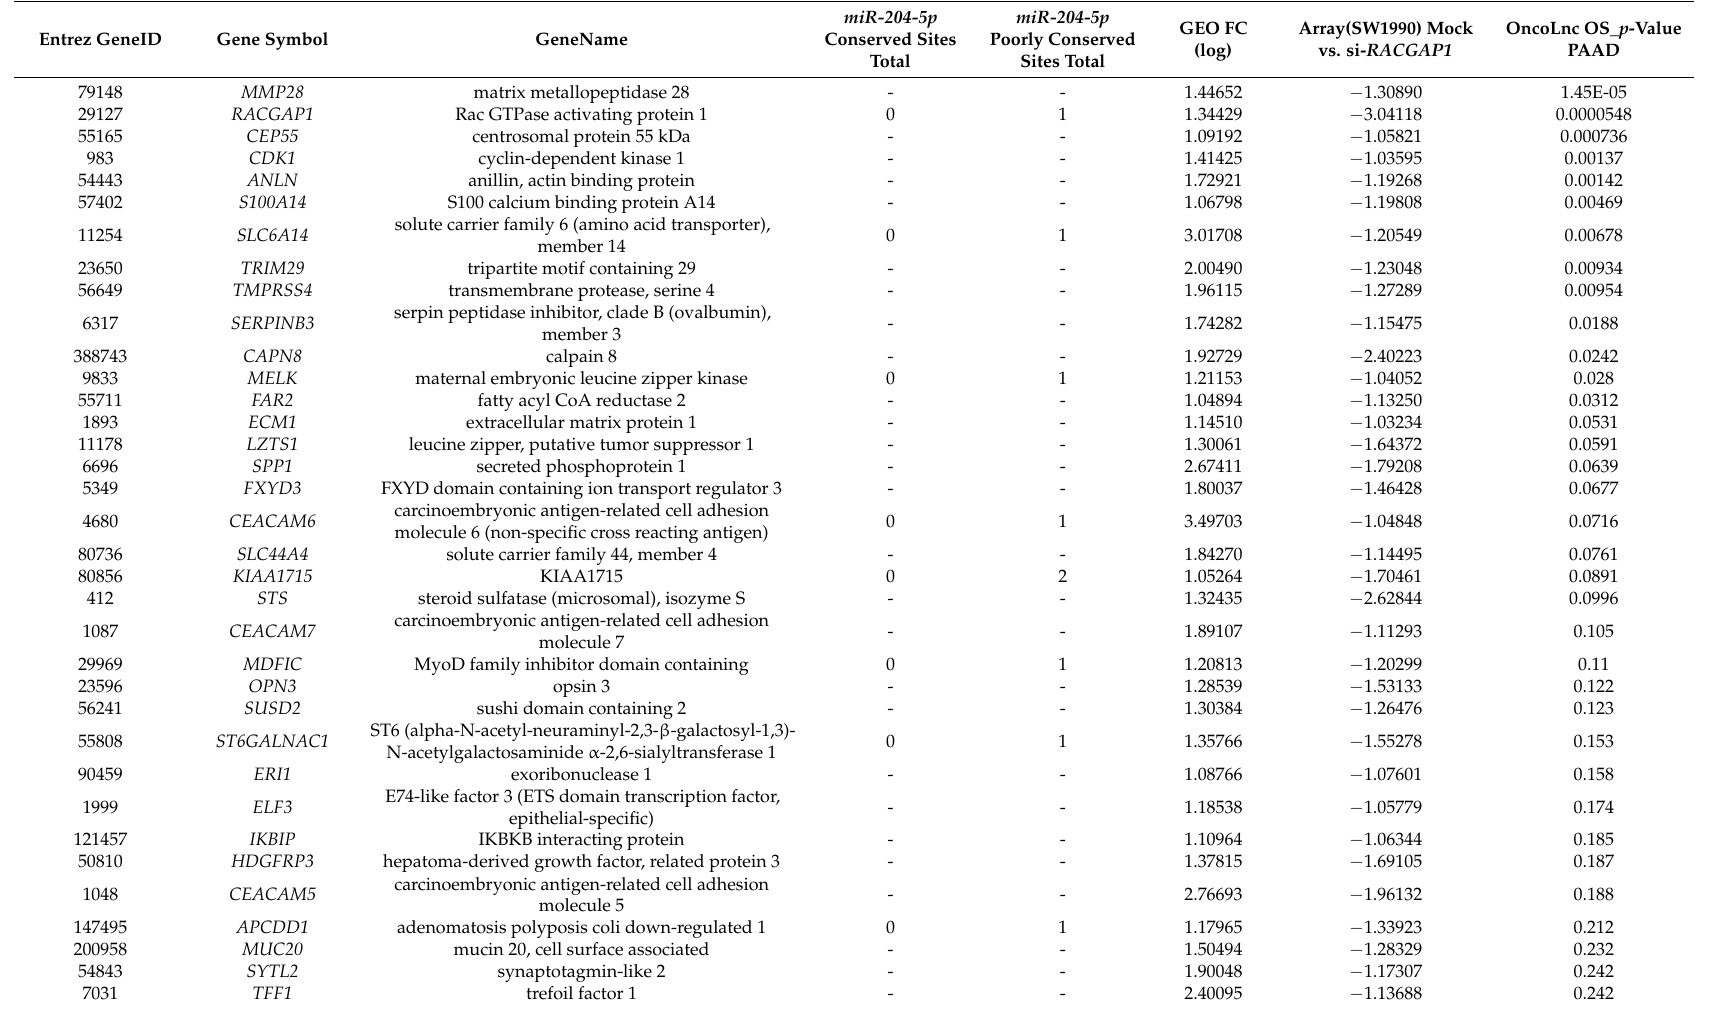
Table 4. RACGAP1 -meditade downstream genes in